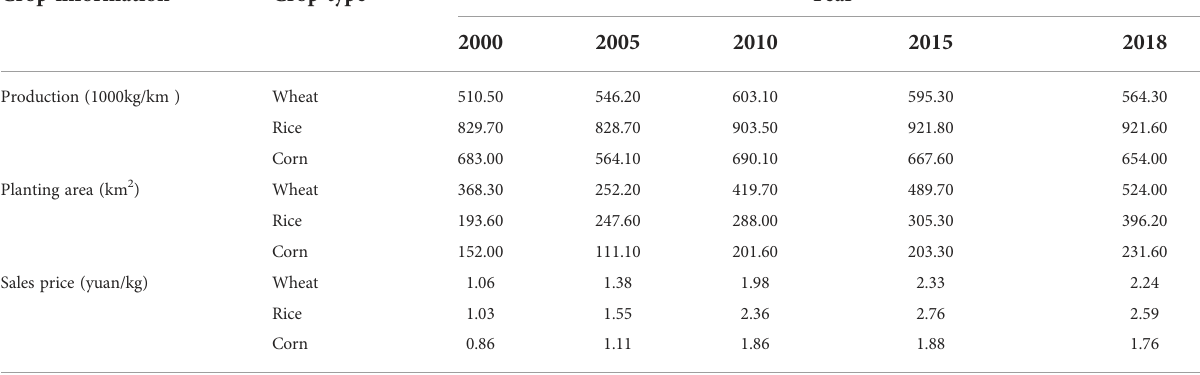
TABLE A1 Crop yield, area and national average selling price. Crop information